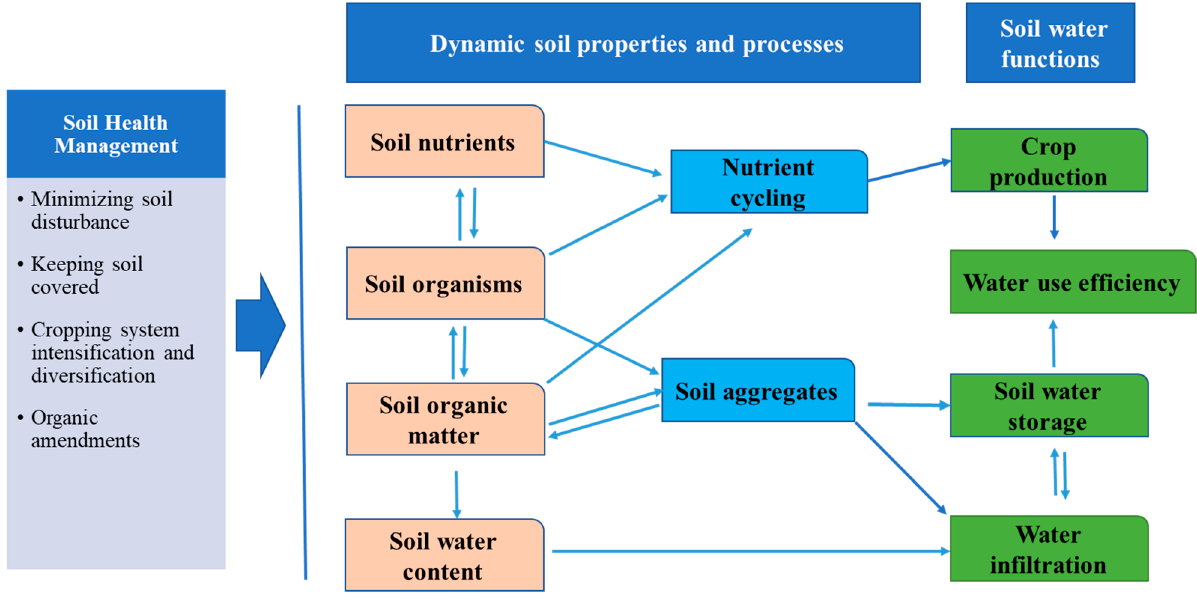
Figure 3. Interactions among soil management, soil health status, and soil functions in a water-lim- ited environment.